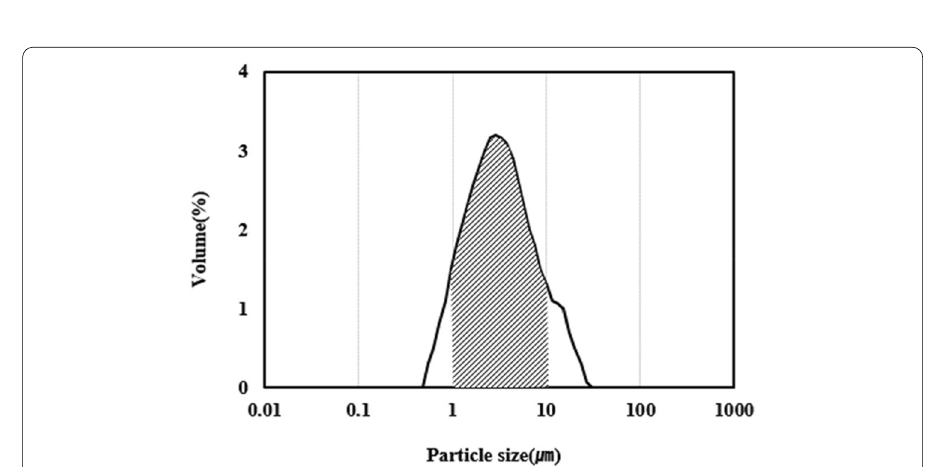
Fig. 6 Particle distribution curve of